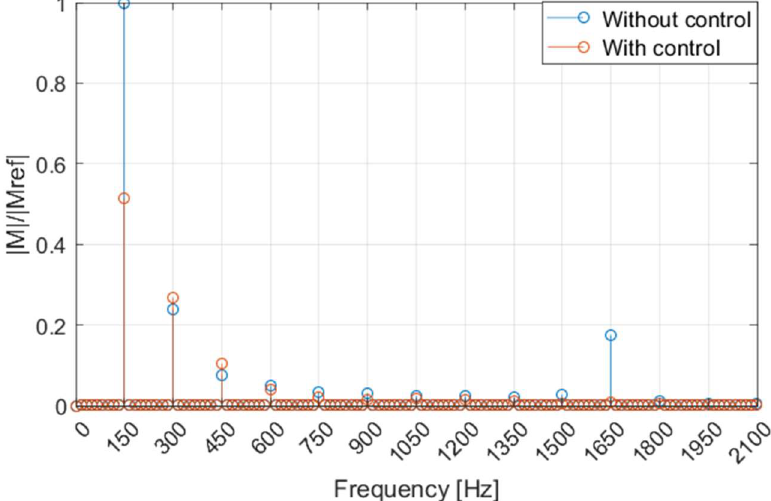
Figure 19. Real pump model with higher spring stiffness. ( a ) Delivery mass flow rate. Shaft speed 1000 r/min; ( b ) Delivery pressure. Shaft speed 1000 r/min.